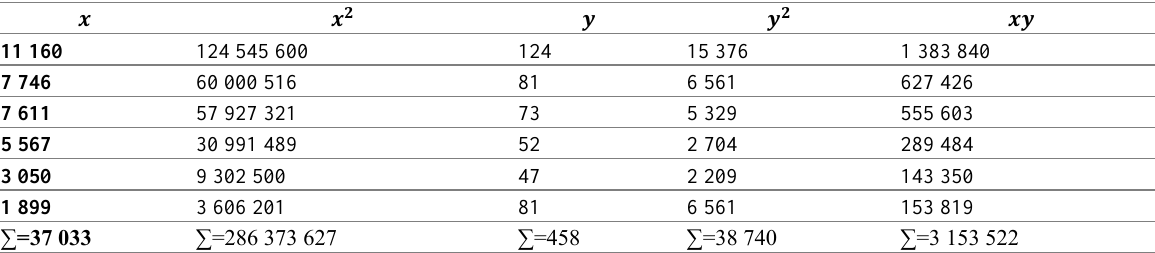
Table 4: Values of the two variables used to calculate the